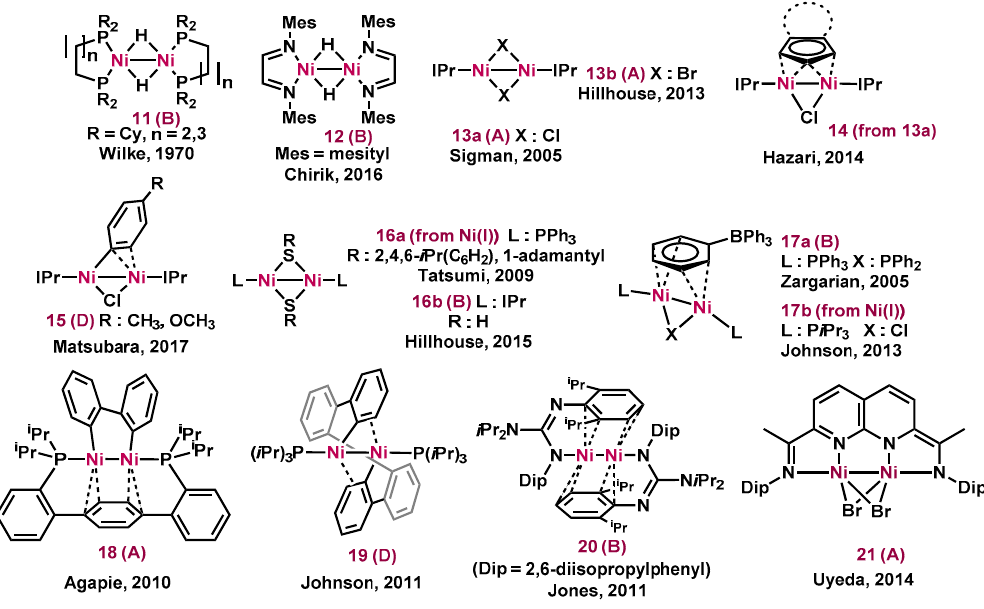
Figure 2. Representative examples of dinuclear Ni(I) complexes. In parenthesis, the synthetic methods A–E are shown.